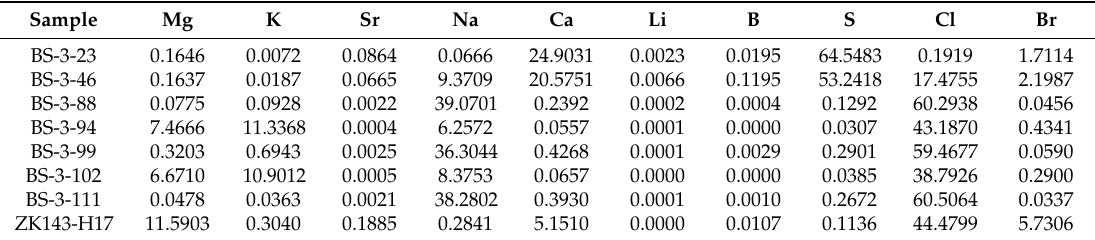
Table 2. Element composition (unit wt %) 1 of mineral samples from the Mboukoumassi deposit,